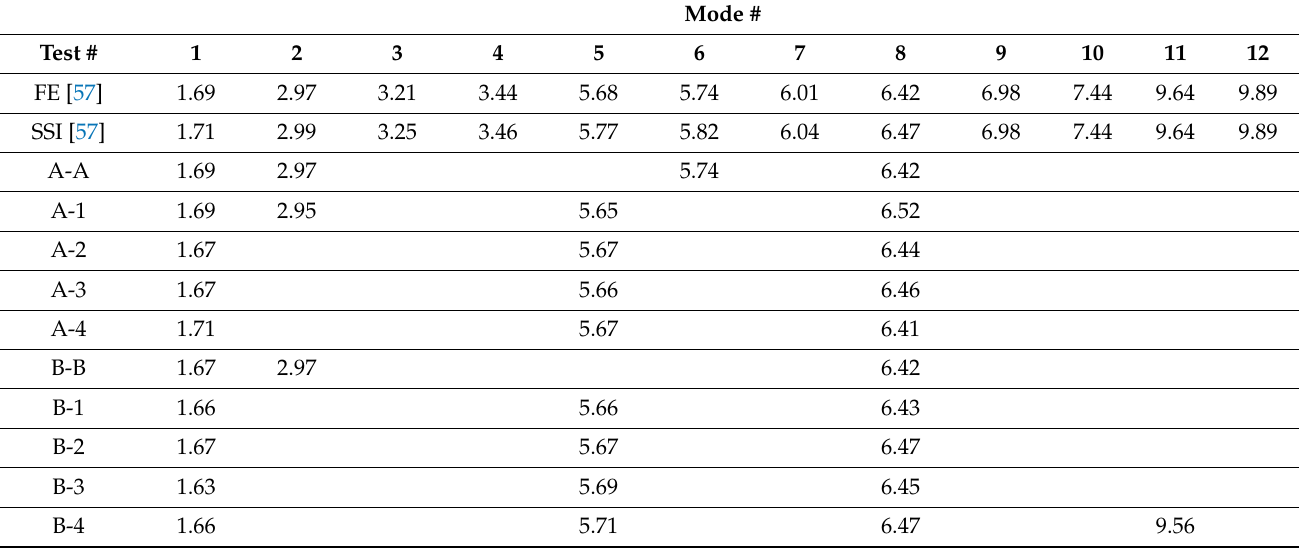
Table 3. Modal frequencies (Hz) of the Eeklo Pedestrian Bridge using SOBI. Mode